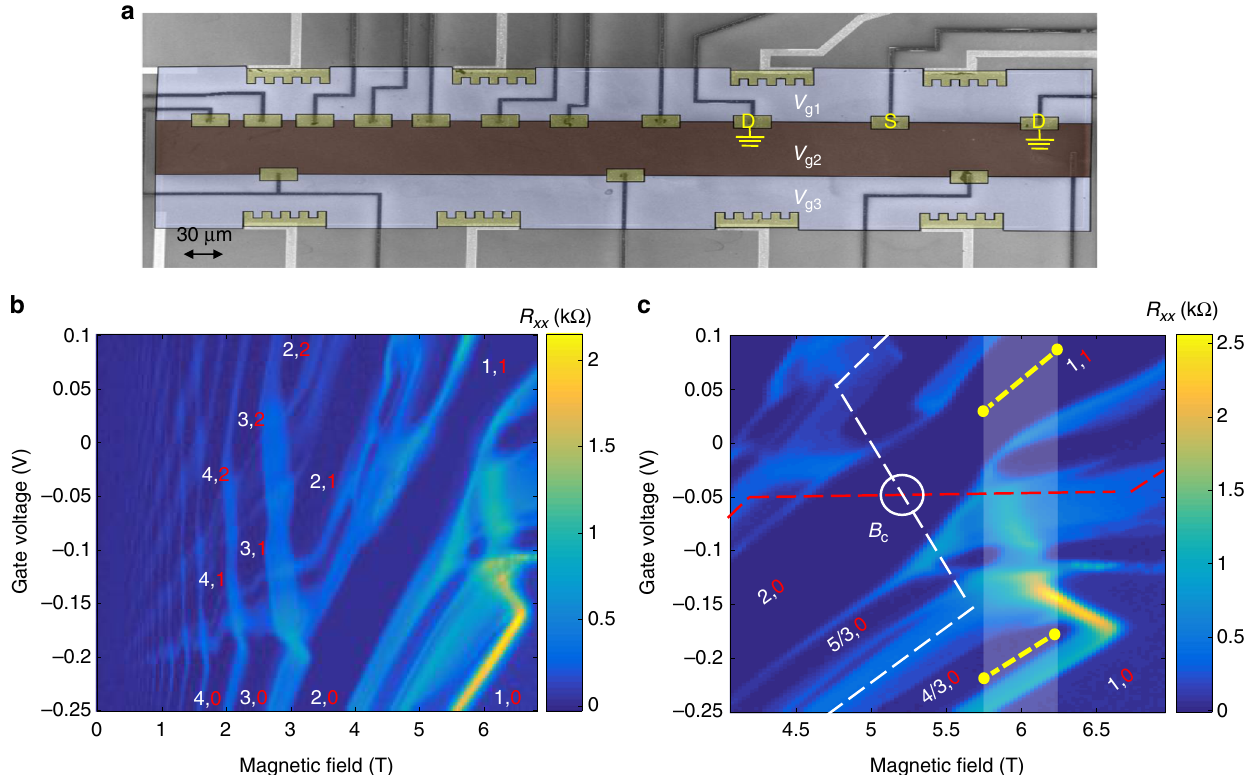
Fig. 2 Device SEM image and fan diagram for the 2DEG. a Scanning electron microscope (SEM) micrograph of the studied device, which is fabricated in a 2DEG embedded in a GaAs/AlGaAs double-quantum well structure. It consists of the upper (light purple), center (brown), and lower (light purple) regions, and the density in each region can be independently controlled by its own top gate, with voltages V g1 , V g2 , and V g3 . A few ohmic contacts are located at the interfaces between two regions (dark yellow squares) and others located away to measure the generalized fi llings of the three regions (dark serrated yellow squares). Each source (S) is placed in-between two drains (D) in order to measure two-terminal conductance. b 2D mapping of the longitudinal resistance, R XX , versus magnetic fi eld and gate voltage V g1 at T = 20 mK. Data are obtained from the ohmic contacts along the edge of the upper region, in a quantum well with 0.7 -nm-thick AlAs barrier, with the adjacent region pinched off. c The zoom-in on the “ interesting ” region used in our work. The white and red dashed lines represent the non-interacting spin-split Landau levels — LL2 in SB1 and LL1 in SB2, respectively. The fi eld B c describes the magnetic fi eld where non-interacting subbands cross and hybridize. The clear vertical square (containing the yellow dashed lines) illustrates the region in magnetic fi eld where a transition between the generalized fi llings of v = (1,1) and v = (4/3,0) can be